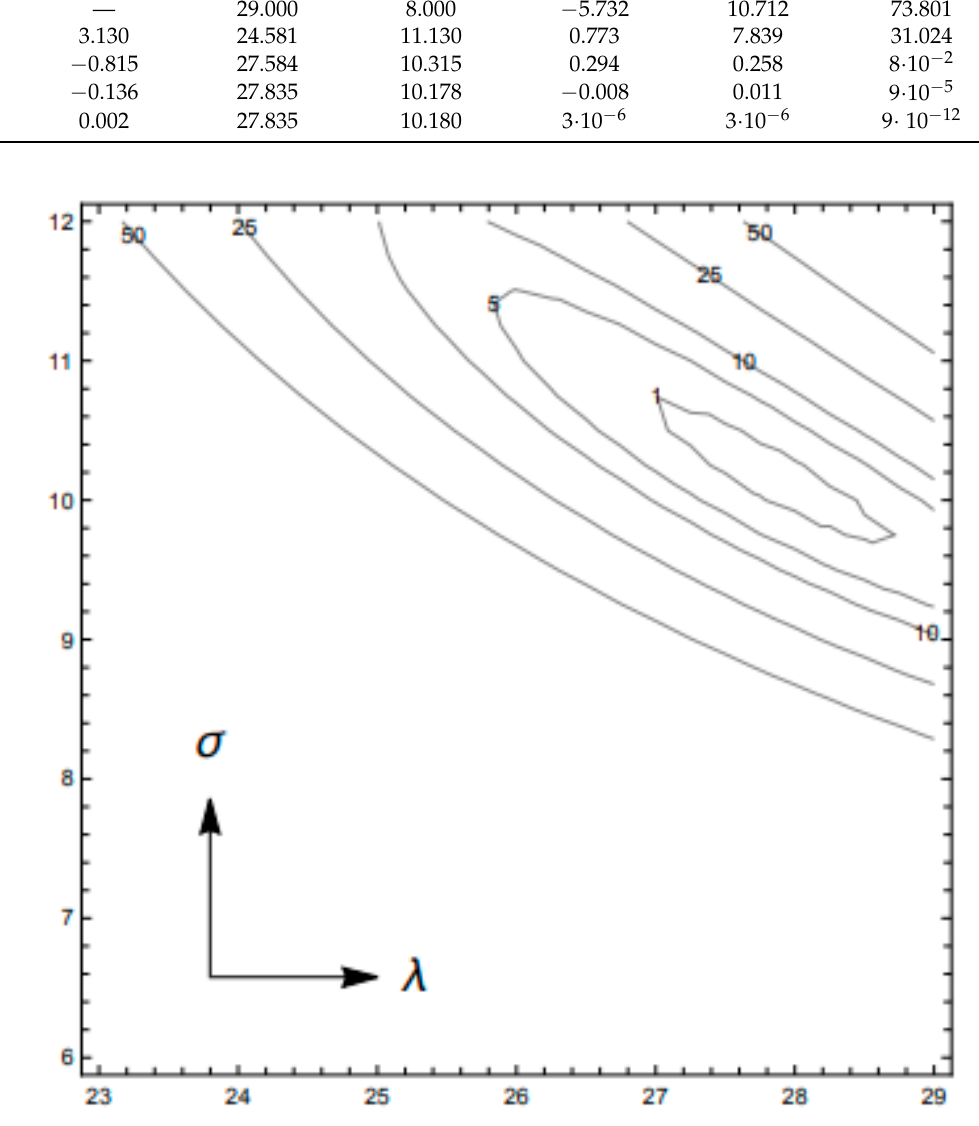
Figure 15. Plot of the cost function based on Equation (32) for the chaotic regime using L-LOM (3). The minimum is located at 𝜆 = 27.6, 𝜎 = 10.3 ( 𝜆 the horizontal axis and 𝜎 the vertical axis).